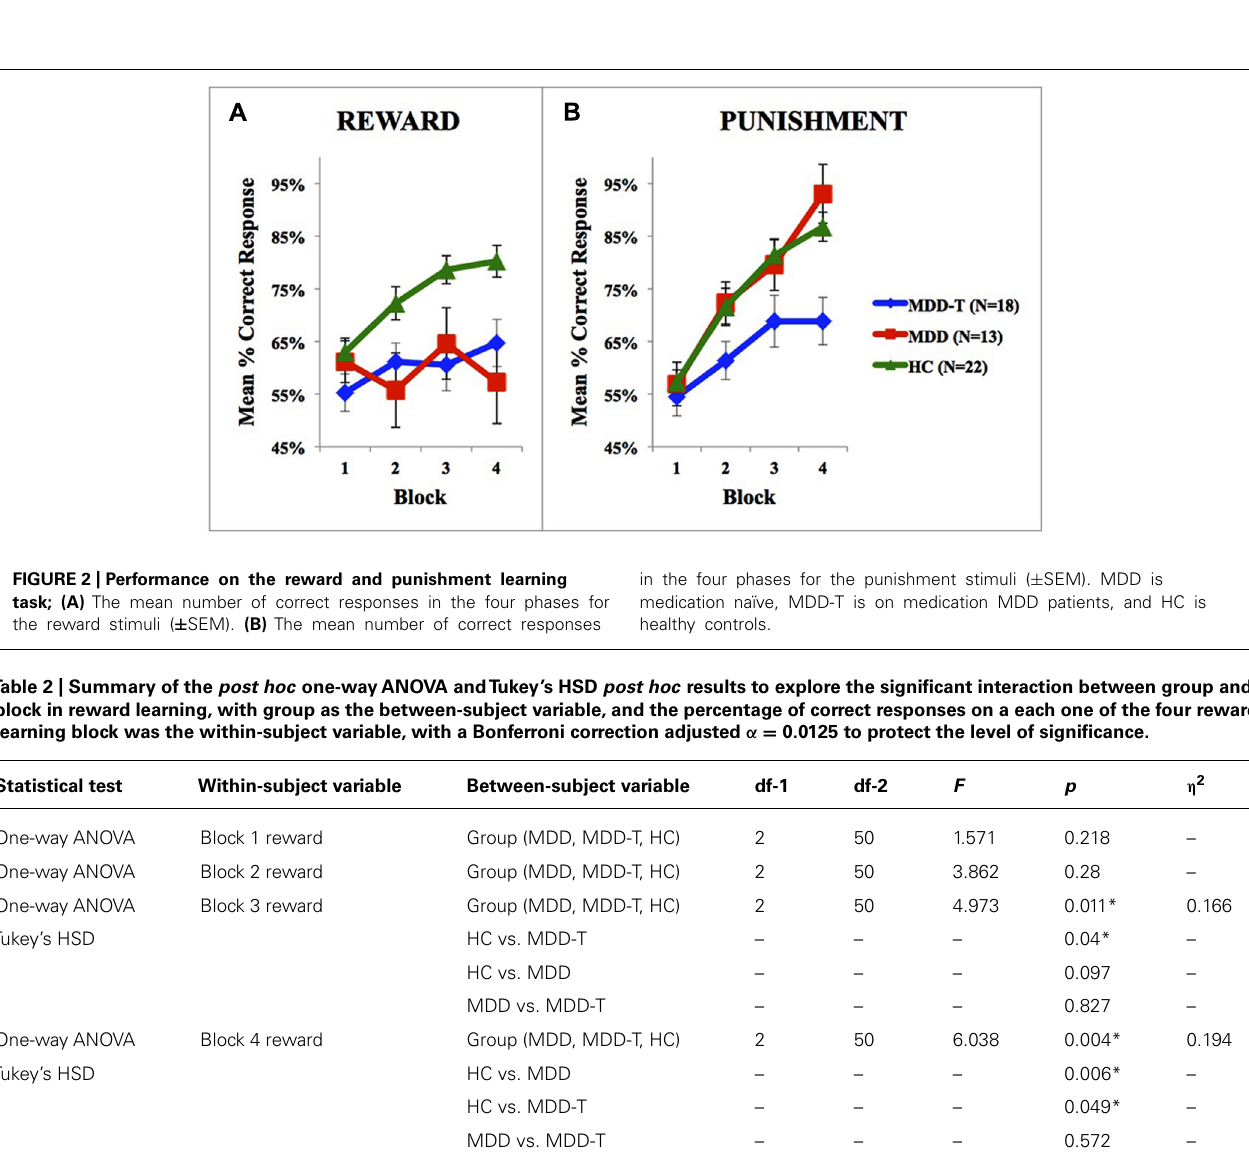
FIGURE 2 | Performance on the reward and punishment learning task; (A) The mean number of correct responses in the four phases for the reward stimuli ( ± SEM). (B) The mean number of correct responses